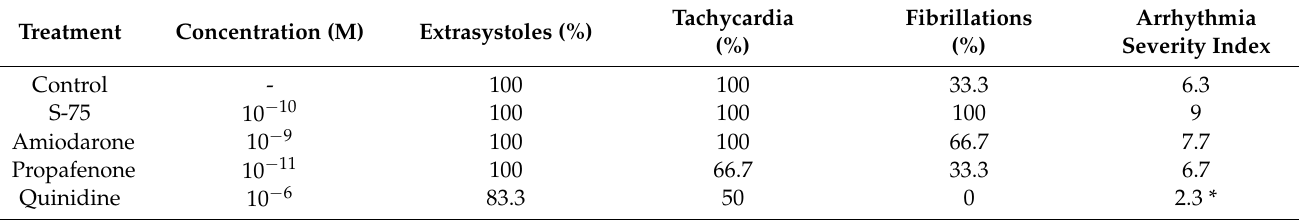
Table 4. The arrhythmic and antiarrhythmic activity of tested and reference compounds in post-reperfusion irregularities of heart rhythm.